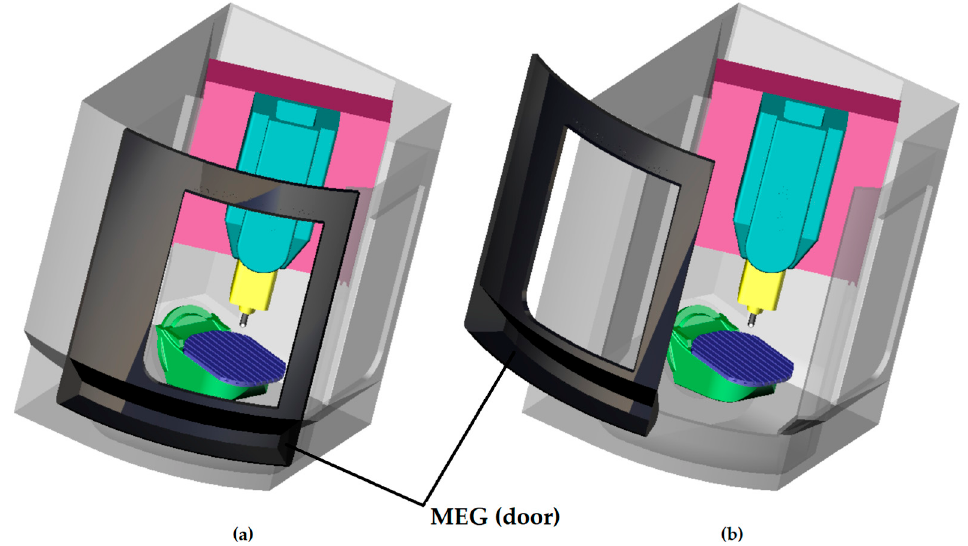
Figure 2. Movable enclosing guard (MEG) for a multi-axis CNC machine tool (door): ( a ) door closed; ( b ) door opened.